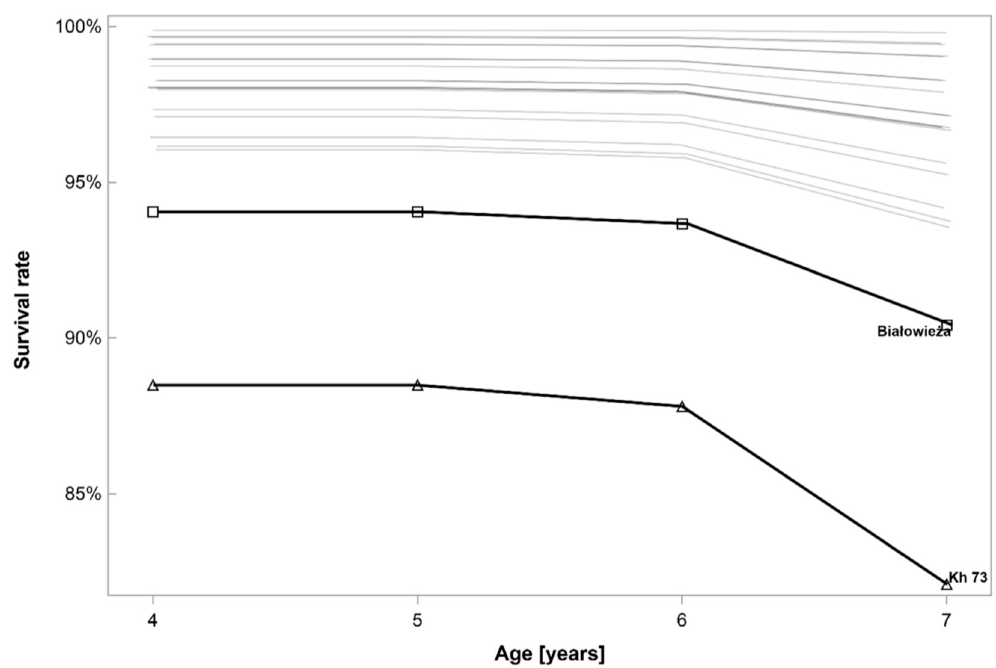
Figure 1. Trend lines in survival rate for clones over time. The bold line with square symbols indicates the trend for a mixture of 30 clones of P. tremula (TA) plus trees from wild populations in the Białowie˙za Forest (Białowie˙za = reference), and the bold line with triangle symbols for the clone with the lowest survival rate.